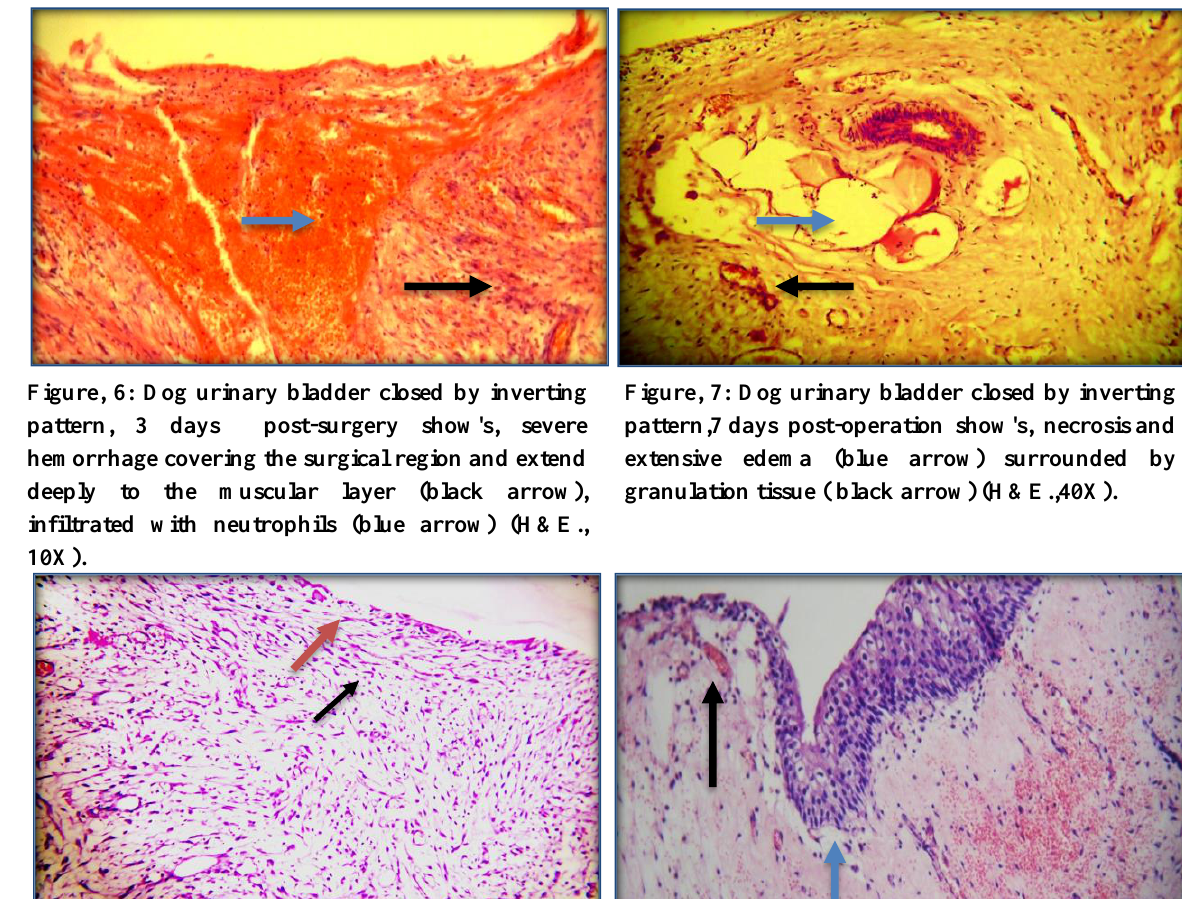
Figure, 9: Dog urinary bladder closed by inverting pattern, 21 days post-surgery show's, proliferation of granulation tissue in the lamina propria of mucosa (black arrow ) and proliferation of several layers of urolithium (blue arrow ) (H&E., 40X).